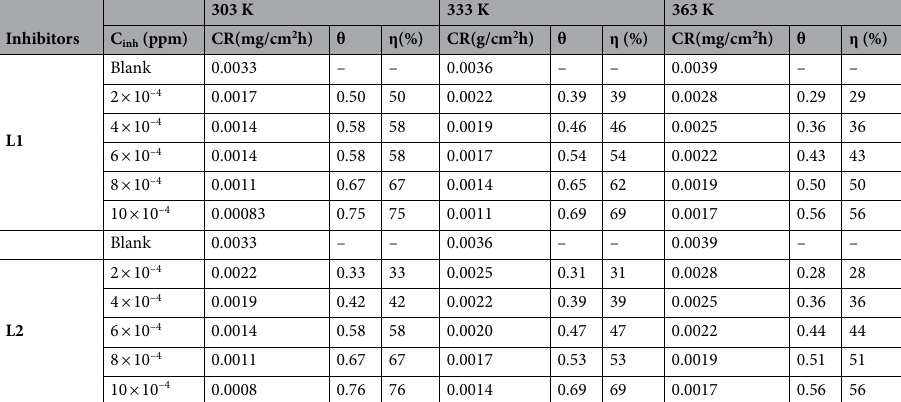
Table 1. Weight loss result of corrosion of mild steel in 0.1 mol L −1 HCl solution without and with varying concentrations of the inhibitors L1 and L2 at temperatures from 303 to 363